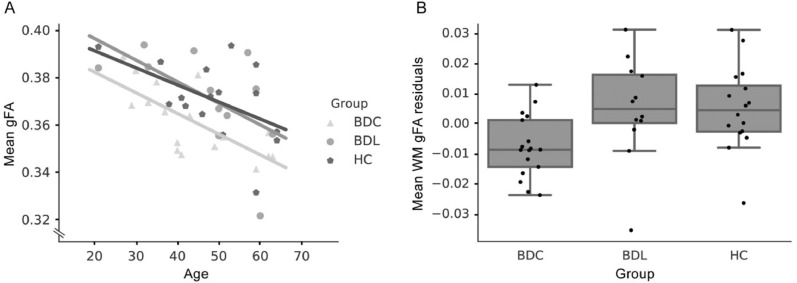
gFA group comparison. (A) Association between mean white matter gFA and age. Each dot is an individual subject and lines indicate the least squared regressions. (B) Group comparison of mean gFA residuals after correction for age and sex.